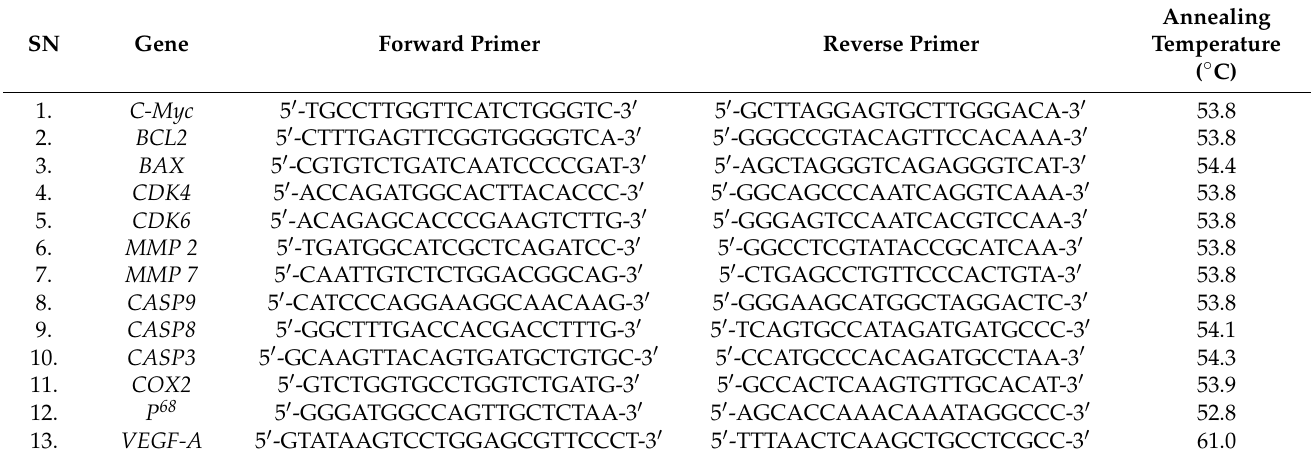
Table 1. List of forward and reverse primers used in this